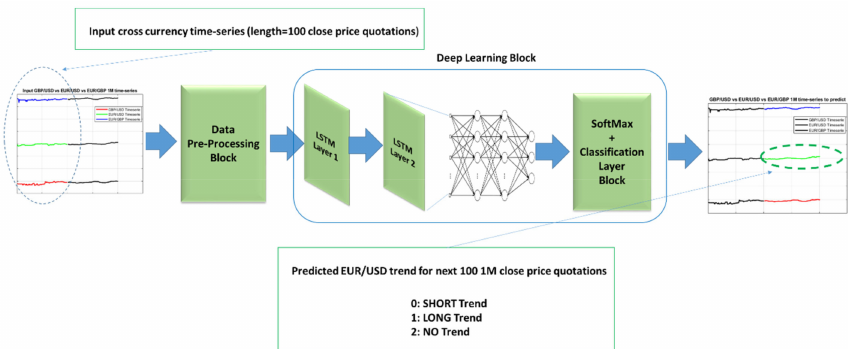
Figure 6. The proposed LSTM based mid-term trend prediction. The input currency time-series is being fed into LSTM input at blocks of close price quotations with a length of 100 (blue / green / red part of the input financial time-series). The output of the deep framework is a trend prediction (0: SHORT; 1: LONG; 2: Trading Range) related to next 100 close price quotations of the EUR /